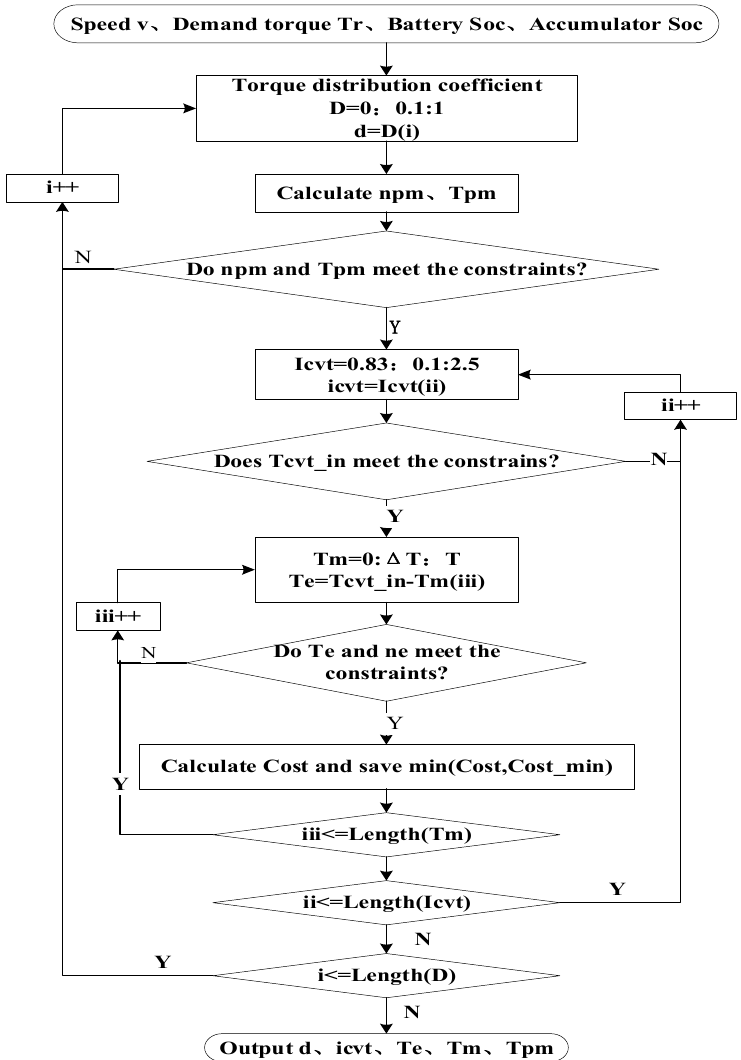
Figure 7. Grid traversal algorithm flow chart.